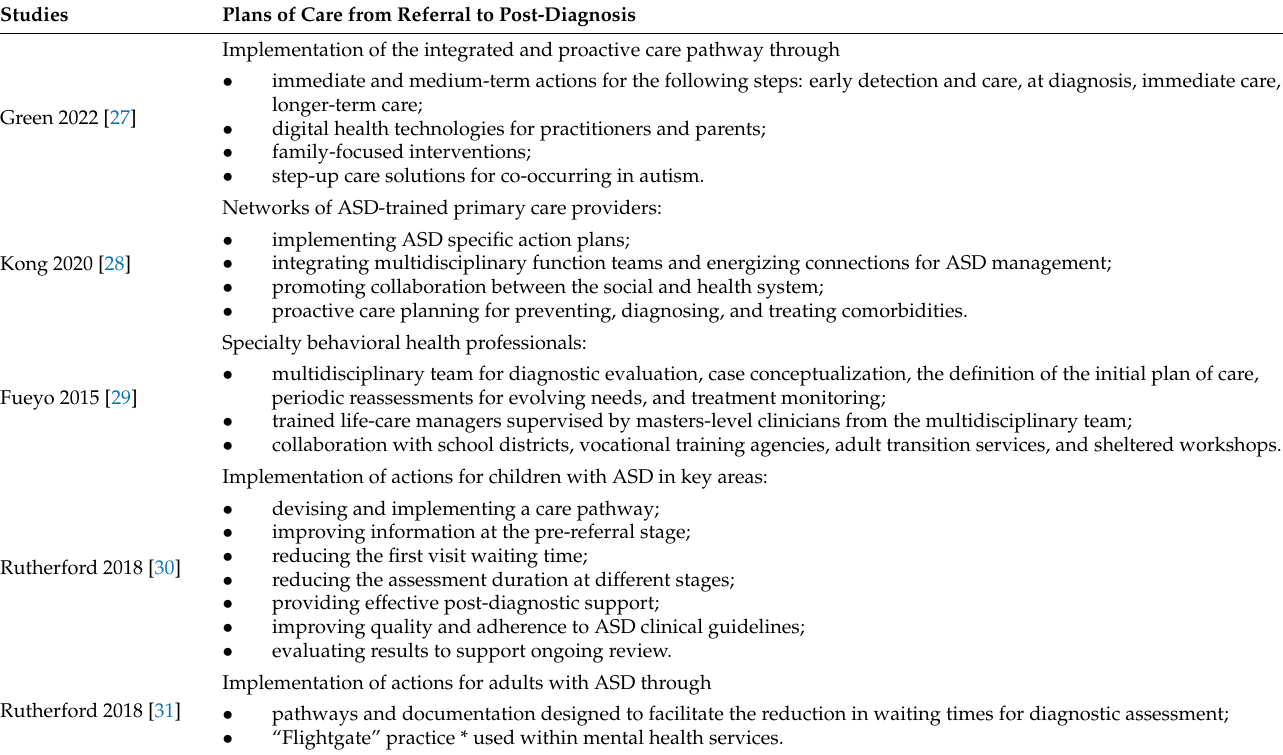
Table 2. Elements of plans of care from recognition to